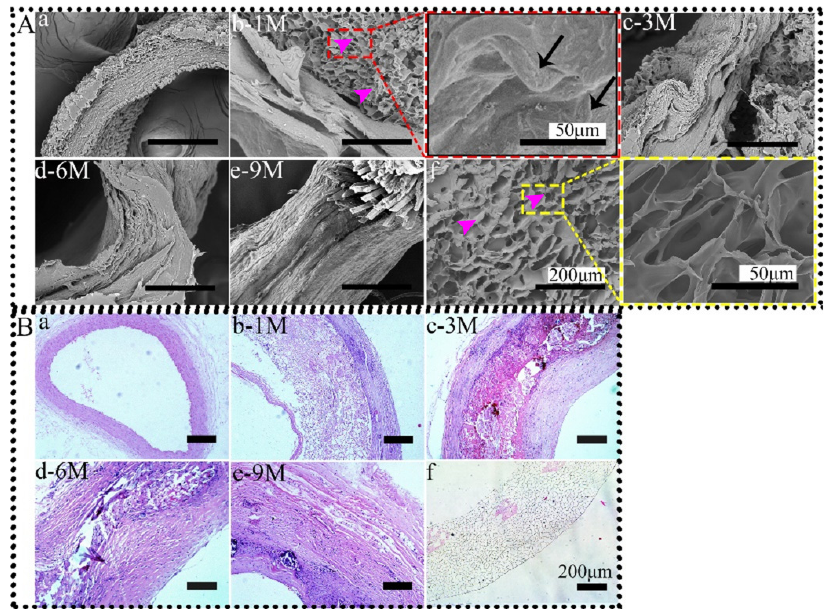
Figure 1. SEM images ( A ) and HE staining ( B ) of SFTSs after implantation. ( a ) Autogenous carotid artery; ( b – e ) represent the different time points after implantation; ( f ) non-implanted SFTS. The scale bar of magnified views is 50 μ m, and others are 200 μ m.